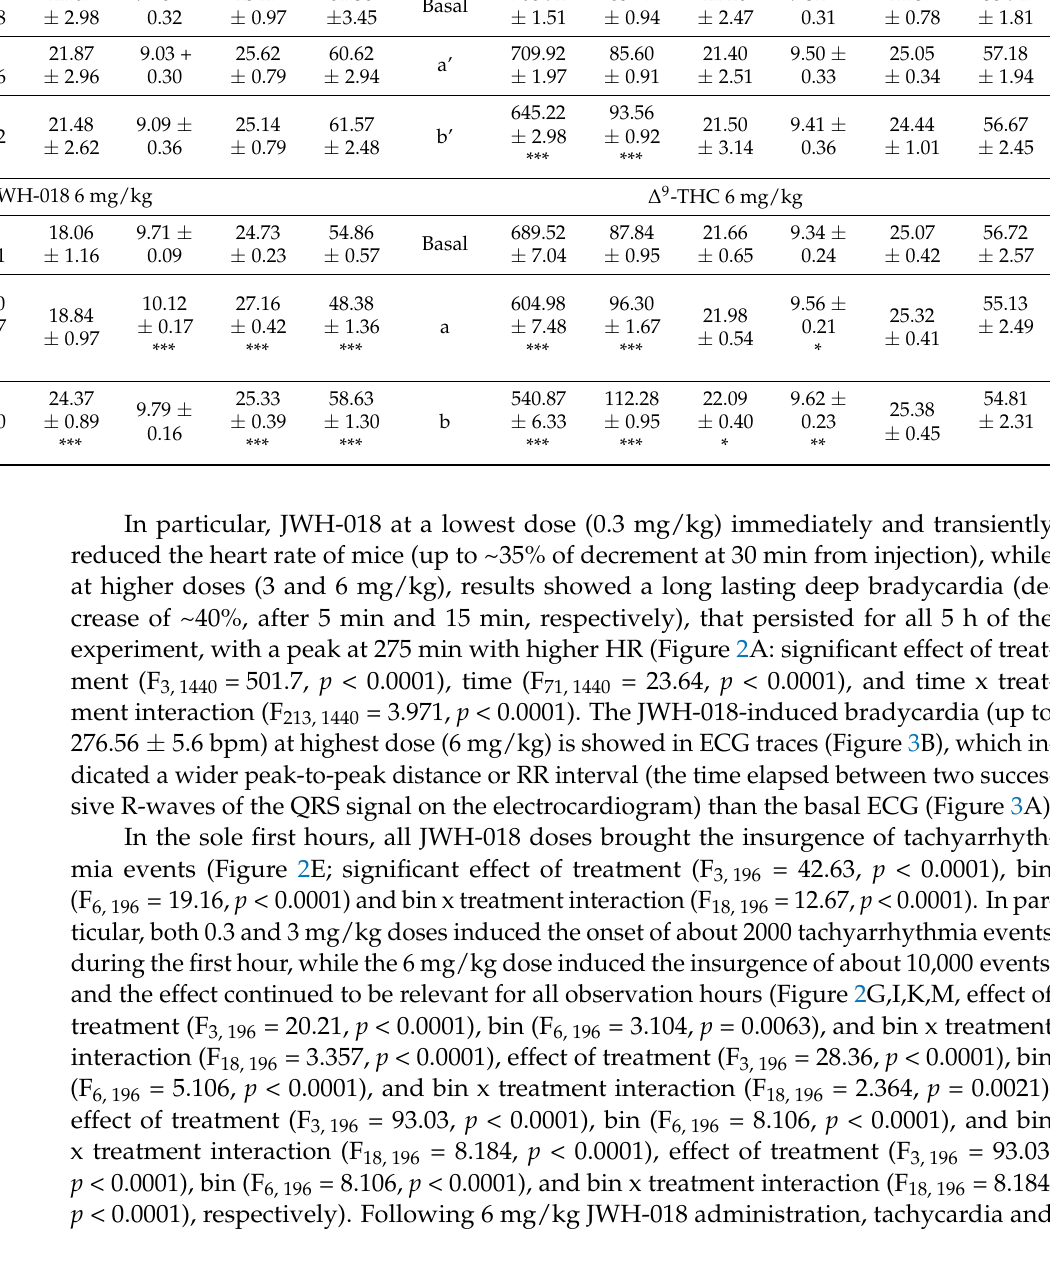
Table 1. Effect of systemic administration of vehicle (a’, b’), JWH-018 6 mg/kg (a and b) and ∆ 9 -THC 6 mg/kg on cardiac electrical parameters (ECG analysis). Data are relative to HR dose–response curve (Figure 2A,B). Data are expressed as mean overall effects of 15 evaluations for baseline and after vehicle or JWH-018 treatment of 4 mice. Data were analyzed with iox2 software, and they are expressed as MEAN ± SEM of evaluations recorded in 1-min time window, capturing data with an acquisition frequency of 1000 Hz. Statistical analysis was performed by Student’s t -test for each ba- sal and after-treating parameter comparisons. * p < 0.05 ** p < 0.01 *** p < 0.001 vs. basal values. HR (bpm; Heart Rate), RR (ms; time between two consecutive peaks), PR (ms; time from the onset of the p wave to the start of the QRS complex), QRS (ms; is the time from the start to the end of the QRS complex), QT (ms; time from the beginning of the QRS complex to the end of the T wave), QTcF (QT/ ∛ RR).